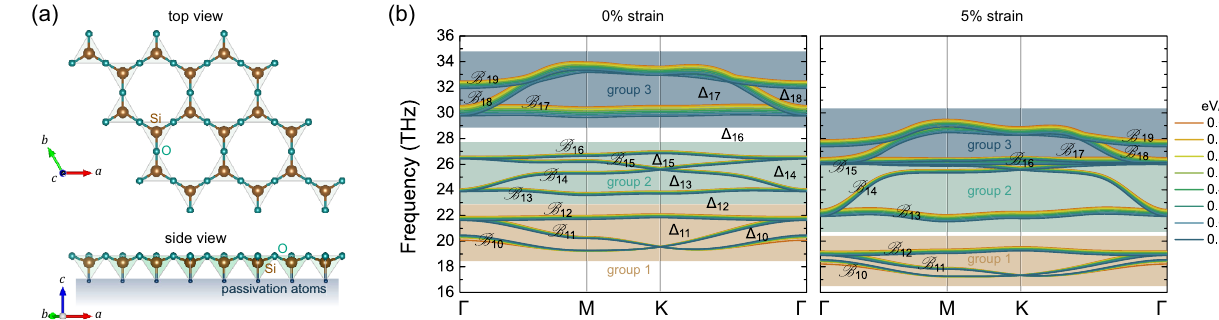
Fig. 1 Phonons in monolayer Kagome silicate Si 2 O 3 . a Crystal structure of monolayer Kagome silicate Si 2 O 3 . b Kagome bands of the phonon spectra of 0 and 5% strained silicate under different electric fi